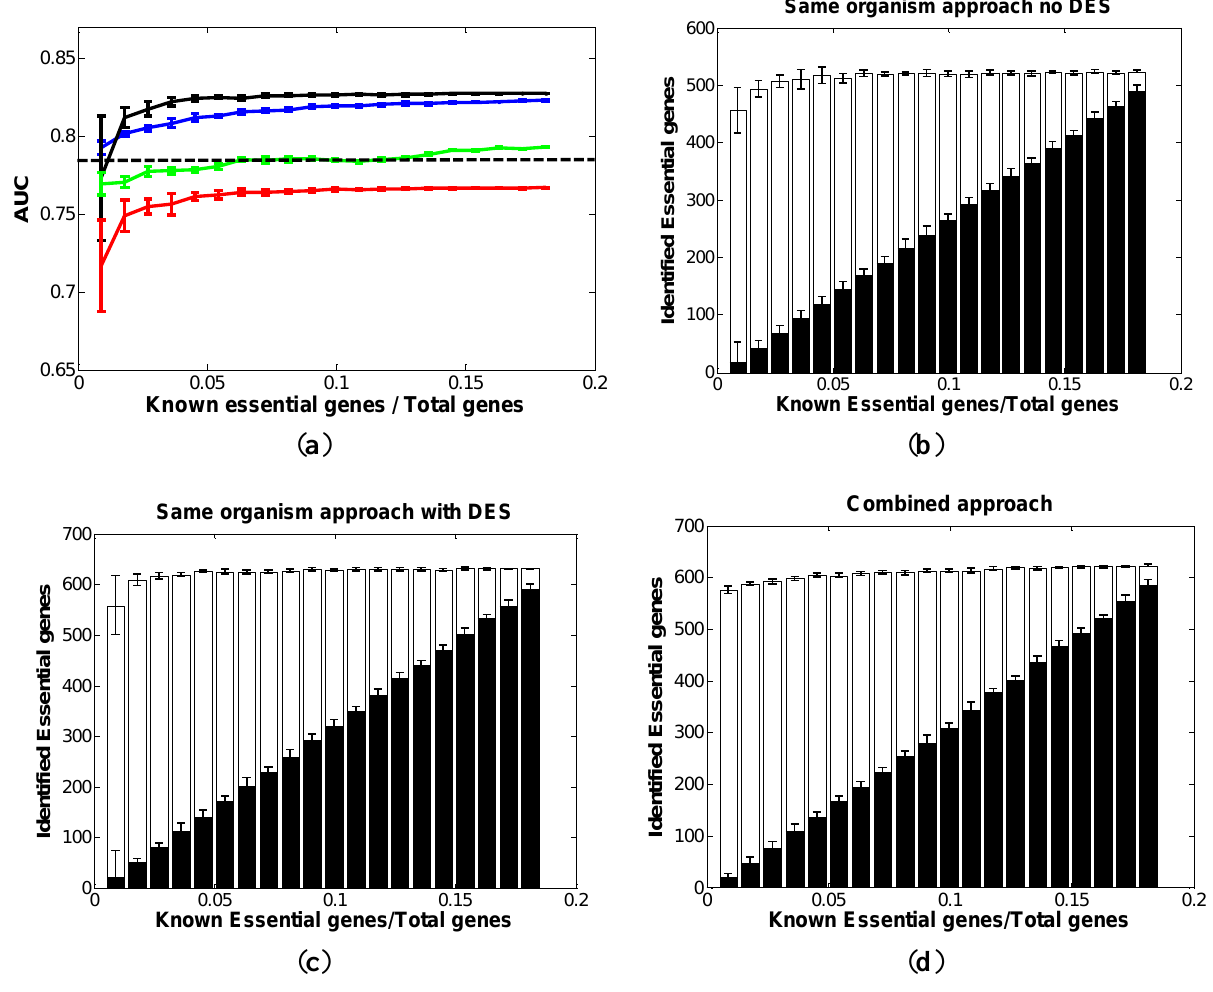
Figure 3. Comparison of three approaches in SC. ( a ) The distribution of AUC along with the different sizes of known essential genes in SC : red curve: same-organism approach “with no-DES”; black curve: same-organism approach “with DES”; blue curve: combined approach; dashed line: cross-organism approach. The bar chart of the correctly classified essential genes among the top 1200 predictions with respect to the different sizes of known essential genes in SC using ( b ) “no-DES” model; ( c ) “with-DES” model; and ( d ) combined model. The black bar shows the correctly classified essential genes in the “gold standard”